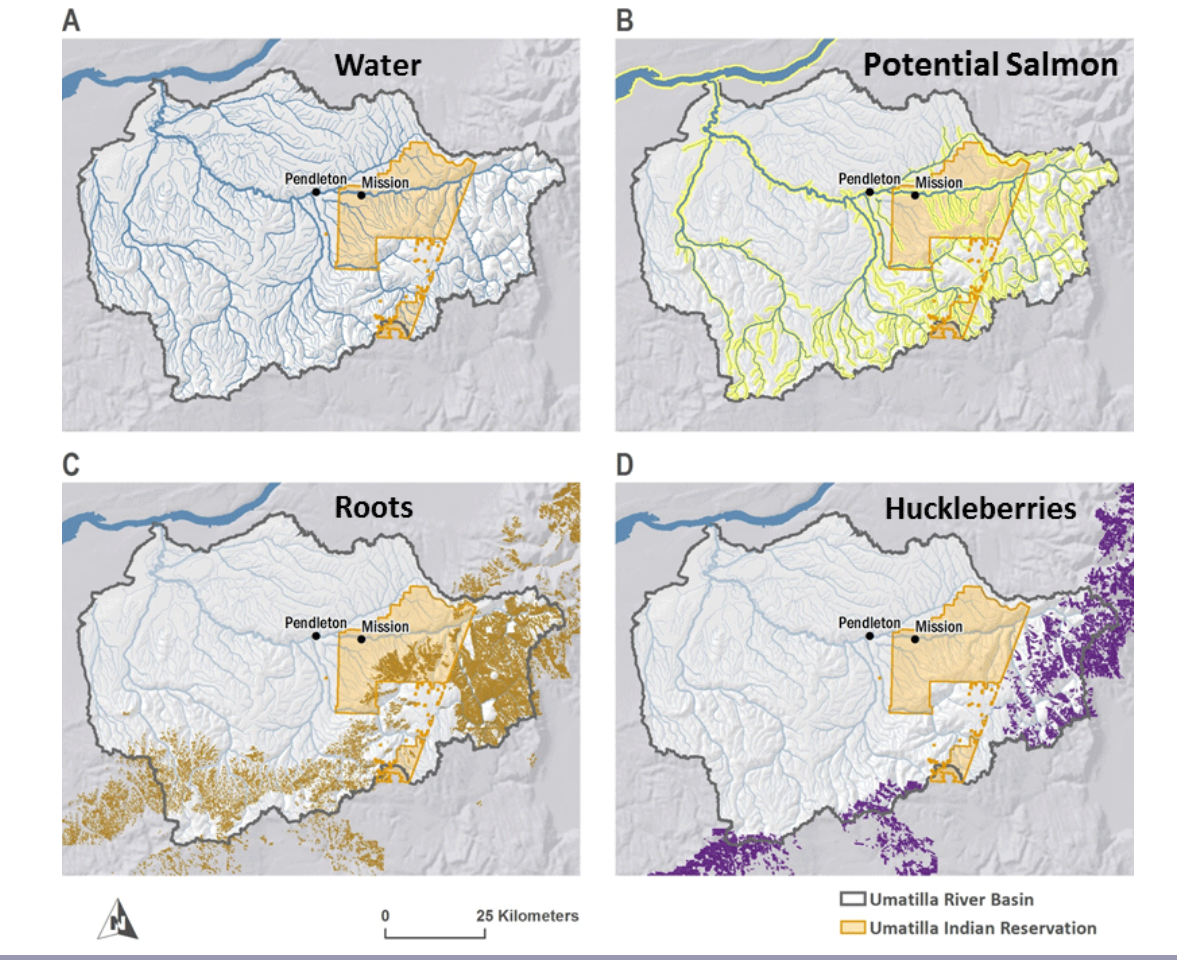
Fig. 2 . Potential distributions of some First Foods of the Confederated Tribes of the Umatilla Indian Reservation, including: (A) Water: the stream network of the Umatilla River from the NHD Plus Version 2 (Horizon Systems 2013), (B) Salmon: the potential range of Pacific salmon (Confederated Tribes of the Umatilla Indian Reservation v. U.S. 1959), (C) Roots: modeled plant distributions associated with roots that serve as First Foods (Schumacher 2014), and (D) Berries: modeled plant distributions associated with huckleberries (Schumacher